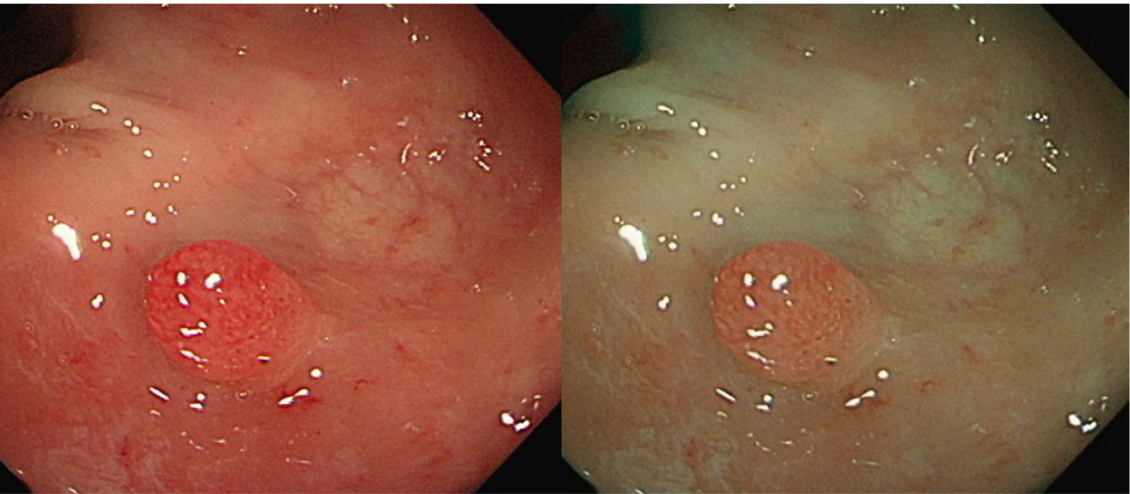
Figure 4. Images of HP polyps after Color Transfer with Mean Shift. (( Left ): Original WL, ( Right ): Color